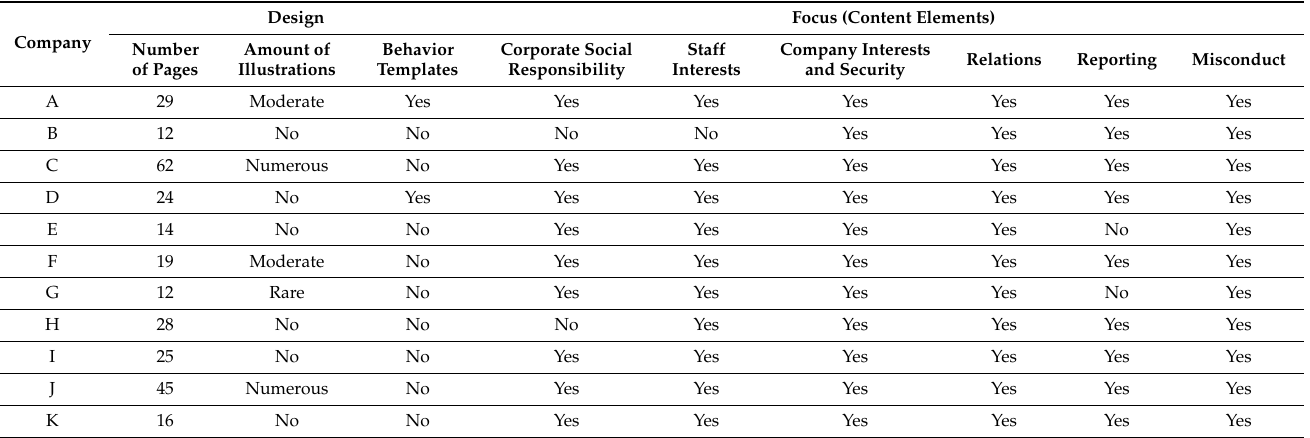
Table 1. General characteristics of the analyzed patriotic codes.